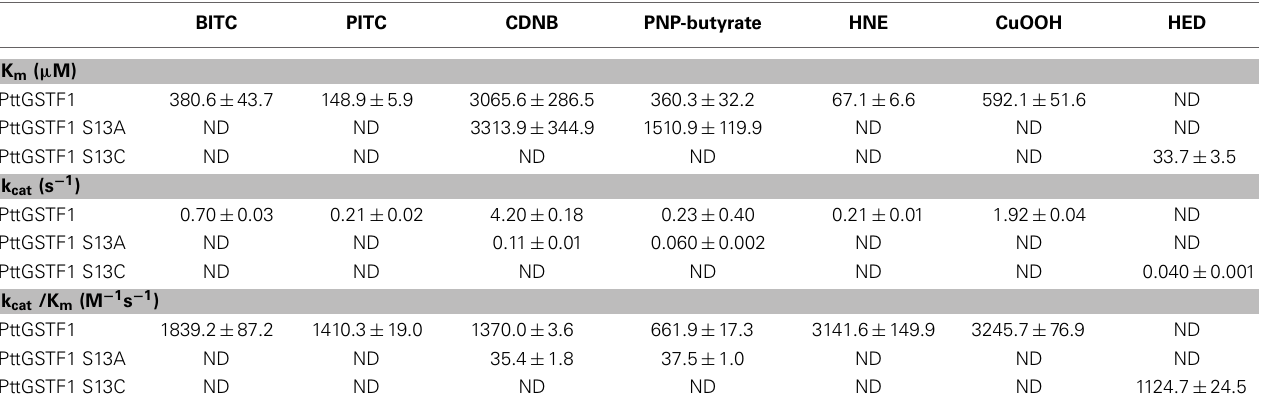
Table 2 | Kinetic parameters of